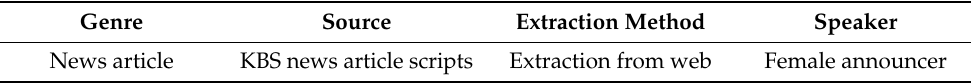
Table 3. Information on the source news script